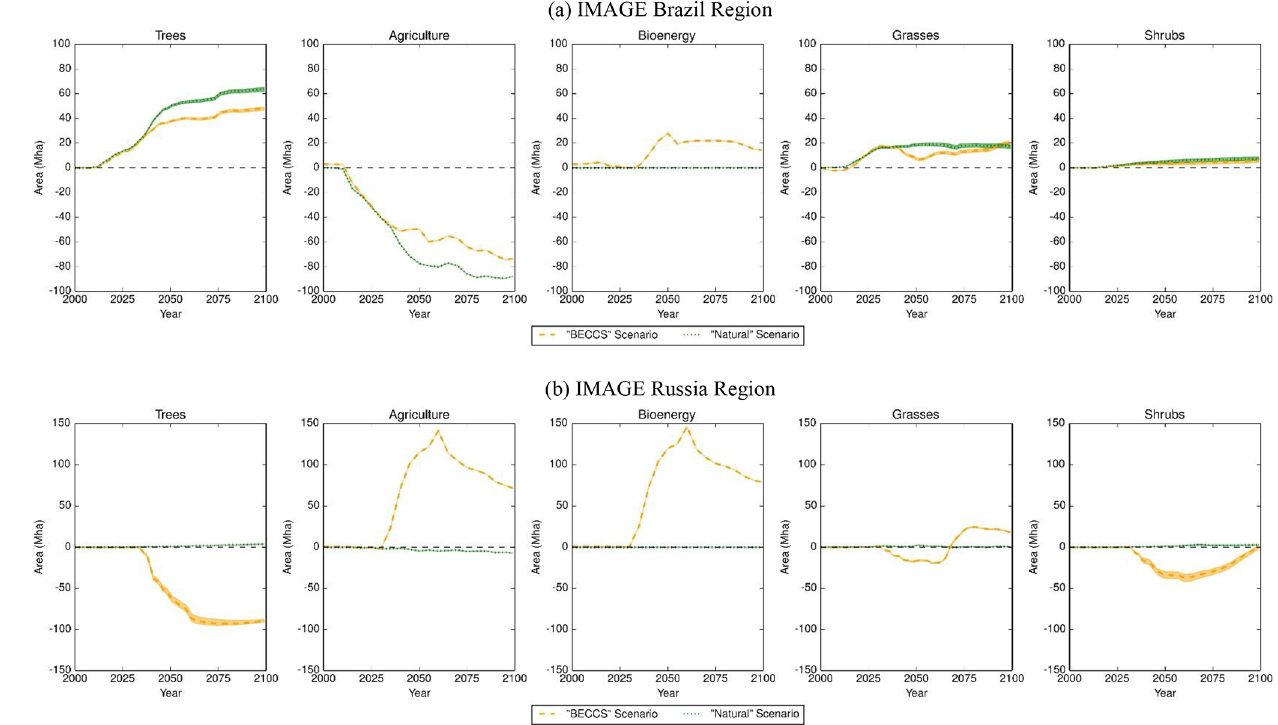
Figure 5. Time series of the land areas (in Mha) calculated for trees and prescribed for agriculture (including bioenergy crops) and bioenergy crops for the BECCS (orange) and Natural (green), as a difference to the baseline scenario (IM-BL), for Brazil (a) and Russia (b) IMAGE regions between 2000 and 2100. The dotted lines are the median and the spread the interquartile range for the 34 GCMs emulated and 4 factorial sensitivity